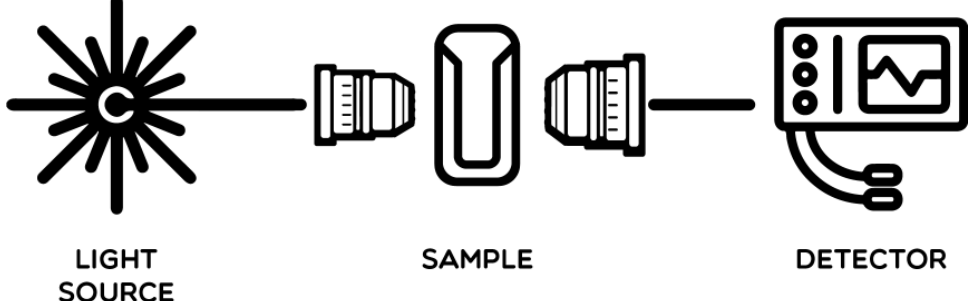
Figure 3. General diagram of the spectrophotometric methods.